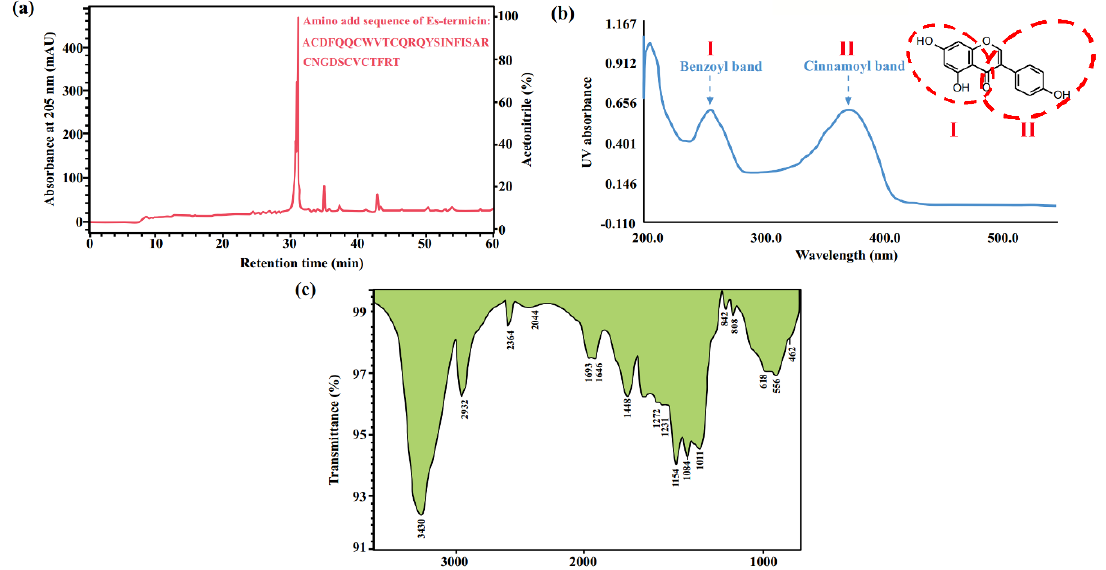
Figure 8. ( a ) The fraction Es-termicin indicated purified by RP-HPLC C 18 column, ( b ) UV spectrum of flavonoids, ( c ) IR spectrum of polysaccharides.